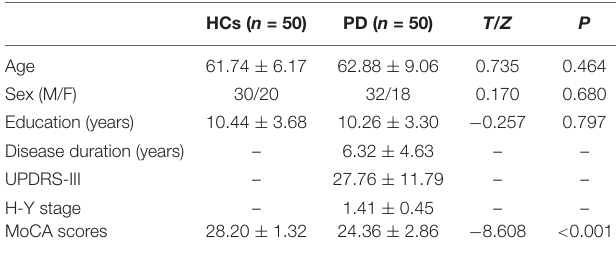
Data are represented as mean ± standard deviation. HC, healthy control; PD, Parkinson’s disease; M, male; F, female; UPDRS, Unified Parkinson’s Disease Rating Scale; H-Y,